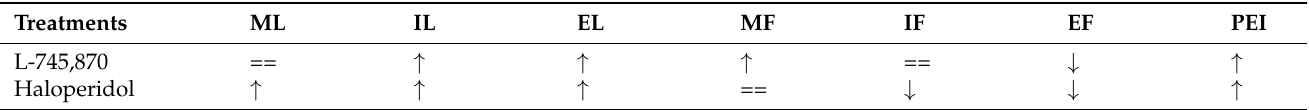
Table 9. Changes in copulatory behavior of sexually potent male rats induced by the D 4 receptor antagonist L-745,870: comparison with haloperidol.